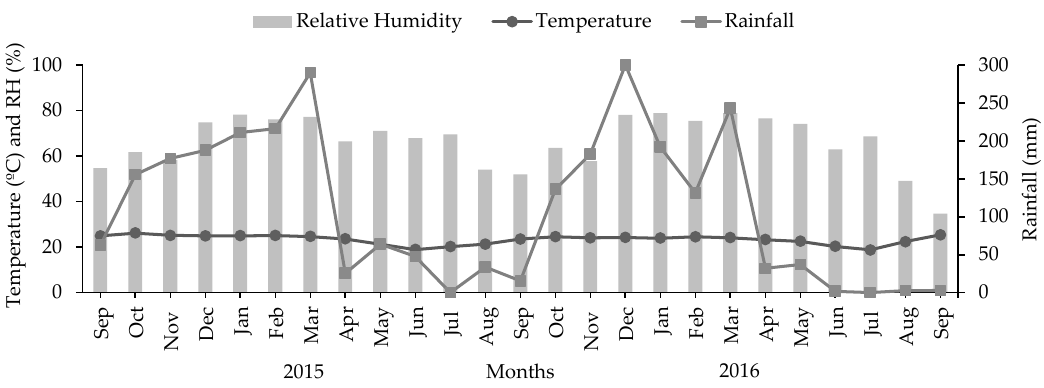
Figure 1. Monthly data on temperature, rainfall, and relative humidity (RH) throughout the experimental period in Jataí-GO, 2015/16. Source: INMET Normal Station-Jataí-GO.